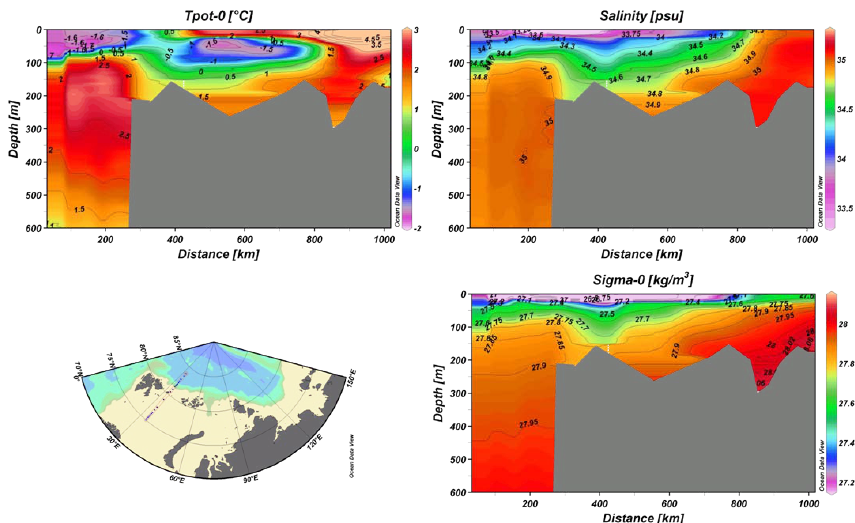
Fig. 3 . Potential temperature, salinity and potential density sections from the SPACE transect along 3 ◦ E from the Barents Sea into the Nansen